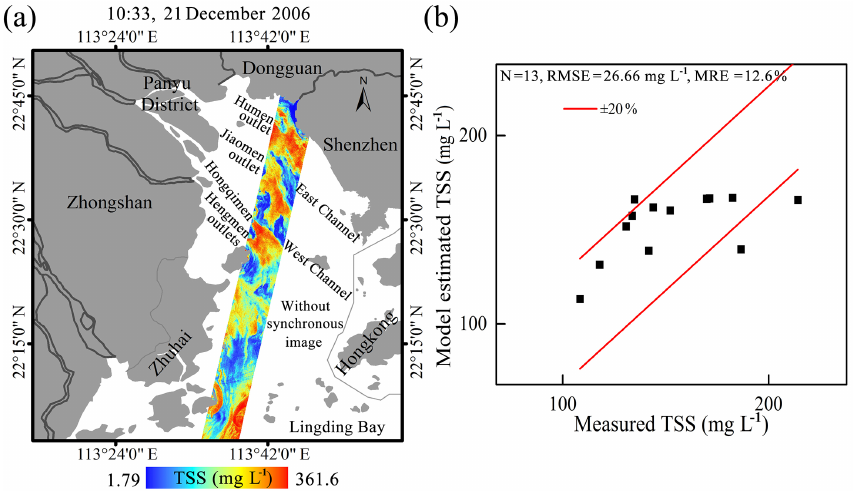
Figure 8. Estimated TSS concentrations based on the QRLTSS model from EO-1 Hyperion imagery in Pearl River estuary at 10:33 (LT), on 21st December 2006 (a) and comparison between the in situ measured and EO-1 Hyperion imagery inversed TSS concentrations (b) . Color scale is the legend of the TSS concentrations, in milligrams per liter (mgL − 1